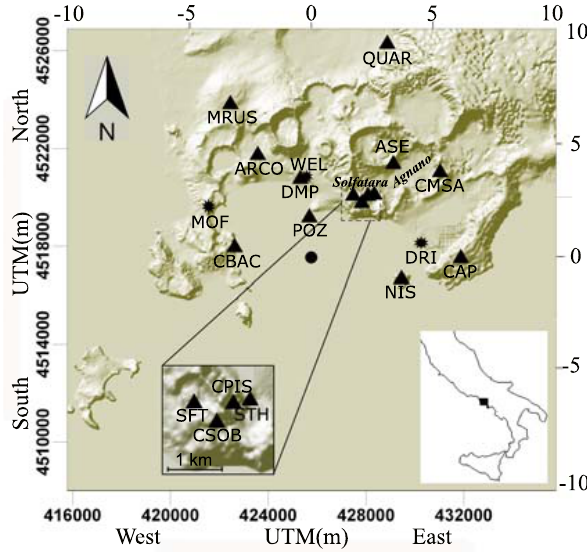
Fig. 1. The Campi Flegrei area, with the stations of the seismic network of the Centro di Monitoraggio of Osservatorio Vesuviano (black triangles). The stars DRI, MOF and WEL indicate the posi- tions of the simulated borehole stations. The black dot indicate the origin of the reference system used in the analysis. In figure both the UTM coordinate in meters (left and bottom axes) and the rela- tive coordinate in kilometers (right and top axes) are